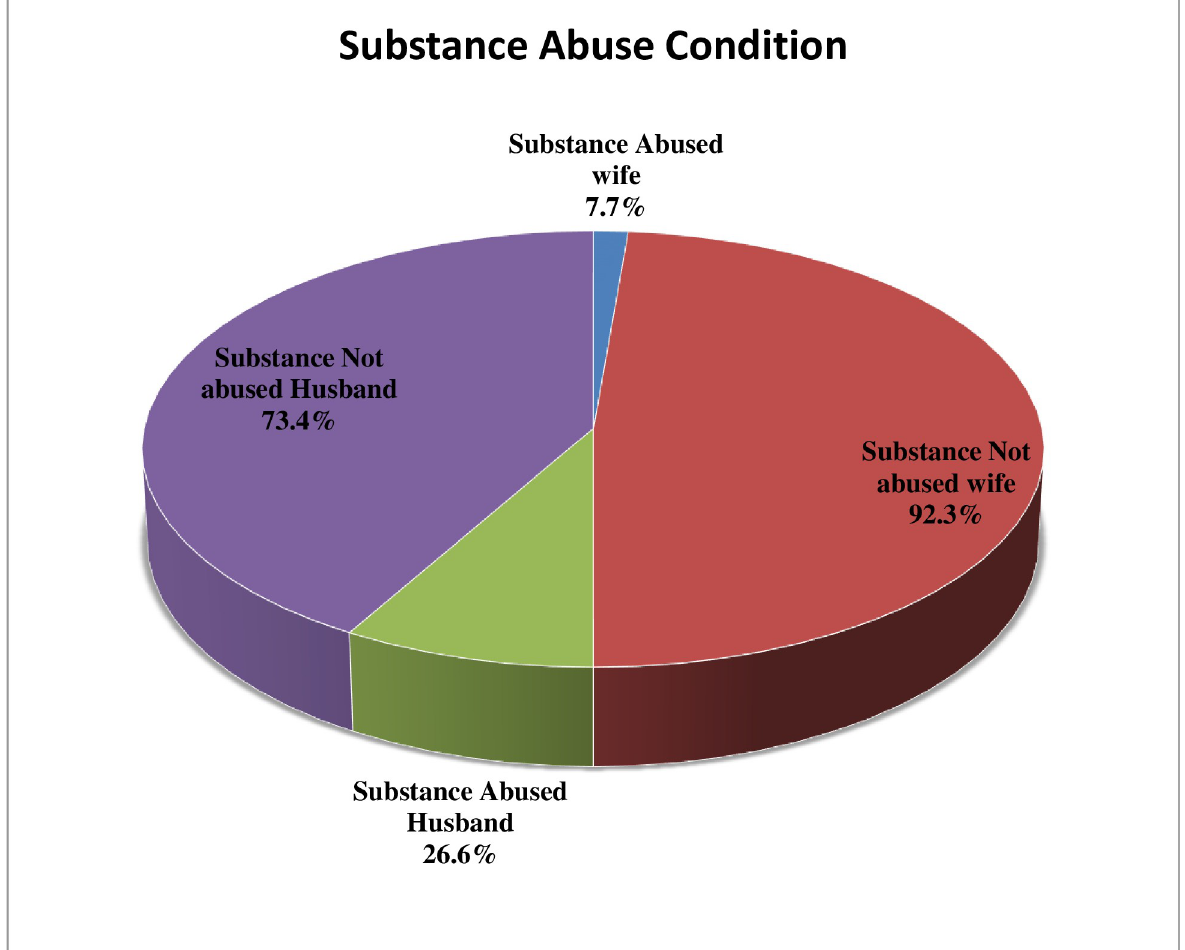
Fig 3. History of substance abuse of study participants and their wives in the study to assess knowledge towards breastfeeding in the Gurage zone, Southern